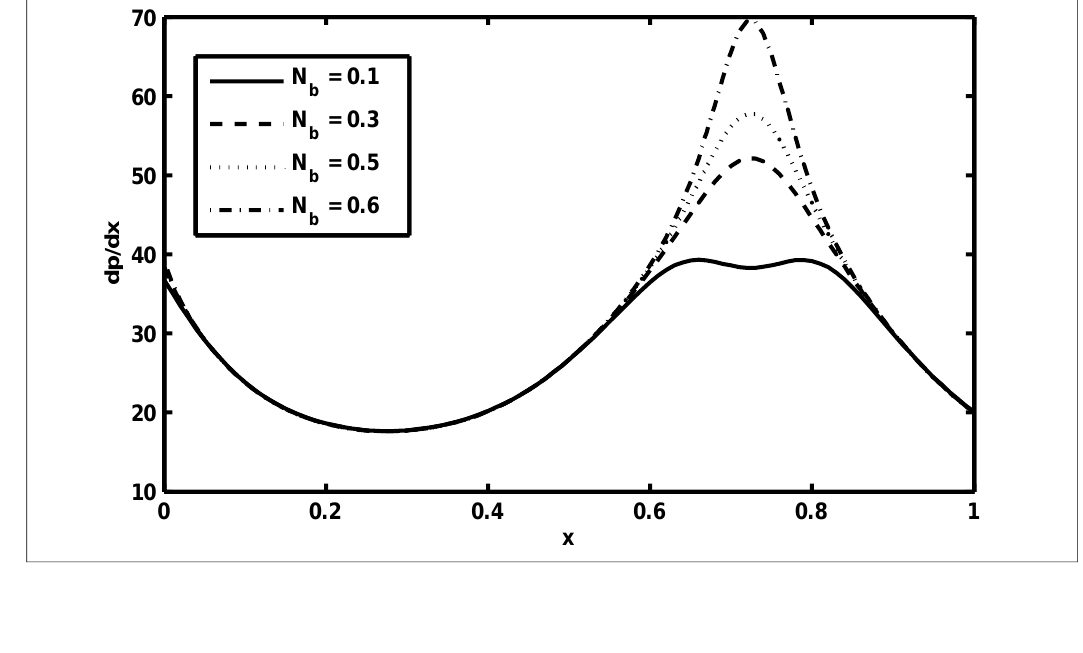
Figure 2. The pressure increase over one wavelength ( Δ𝑝 ) against the volume flow rate ( 𝑄 ): ( a ) 𝑁 𝐶𝑇 = 0.3, 𝑁 𝑇𝐶 = 0.7, 𝐺 𝑟𝑐 = 0.4, 𝐺 𝑟𝐹 = 0.1, 𝐺 𝑟𝑡 = 0.5, 𝑁 𝑡 = 0.7, 𝑁 𝑏 = 0.2, 𝑀 = 4, 𝜙 = 𝜋 0.8 𝑚 = 0.4 ; 𝑁 𝐶𝑇 = 0.3, 𝑁 𝑇𝐶 = 0.7, 𝐺 𝑟𝑐 = 0.4, 𝐺 𝑟𝐹 = 0.1,𝐺 𝑟𝑡 = 0.5, 𝑁 𝑡 = 0.7, 𝑁 𝑏 = 0.2, 𝑀 =